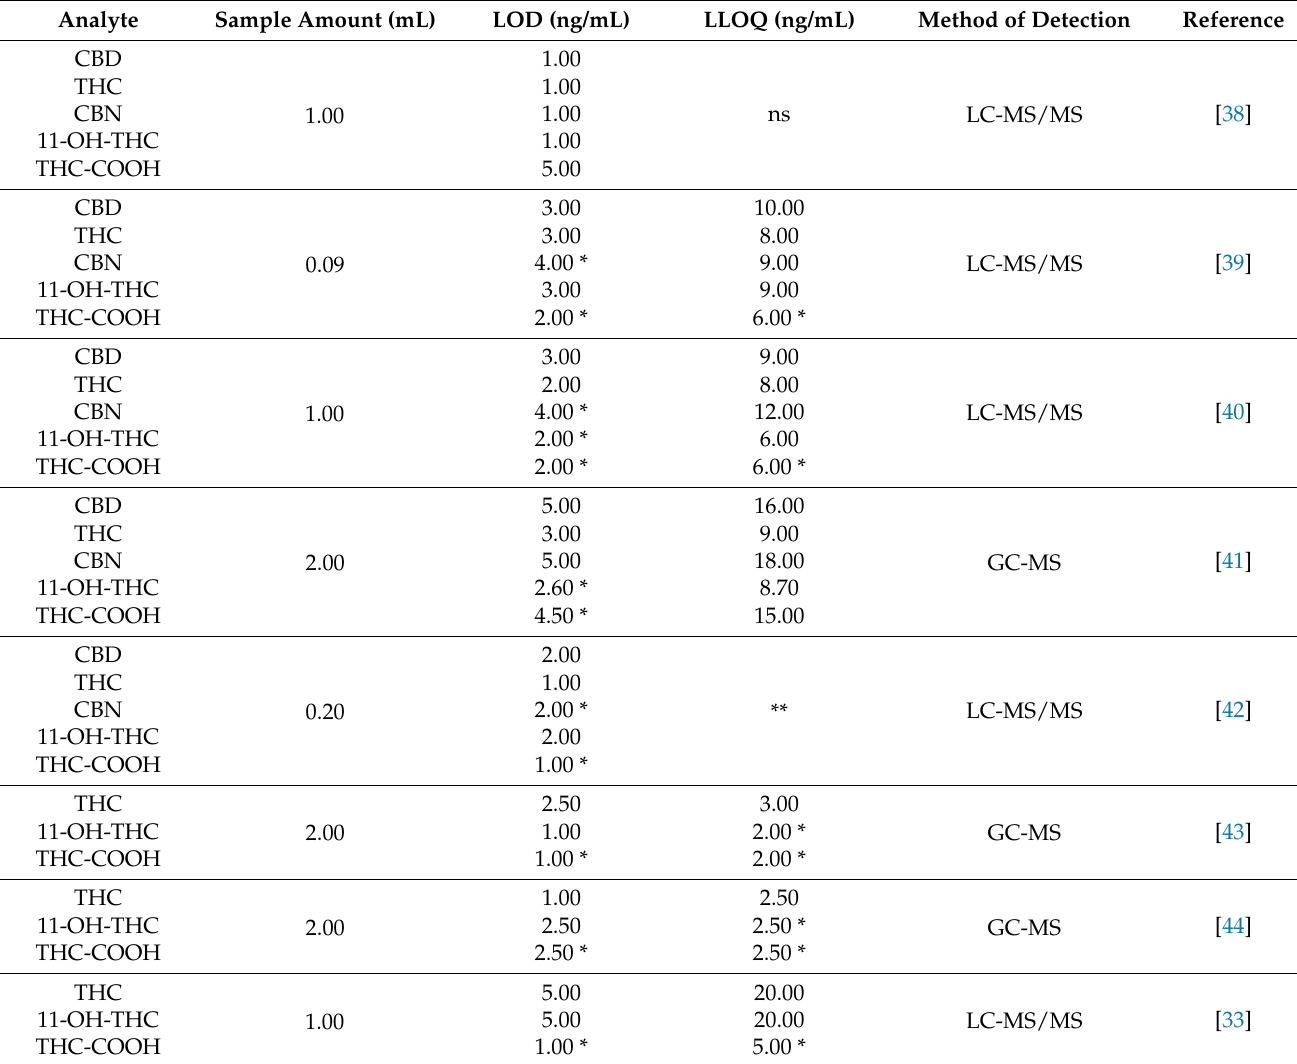
Table 2. Comparison of limits of detection and quantification of several